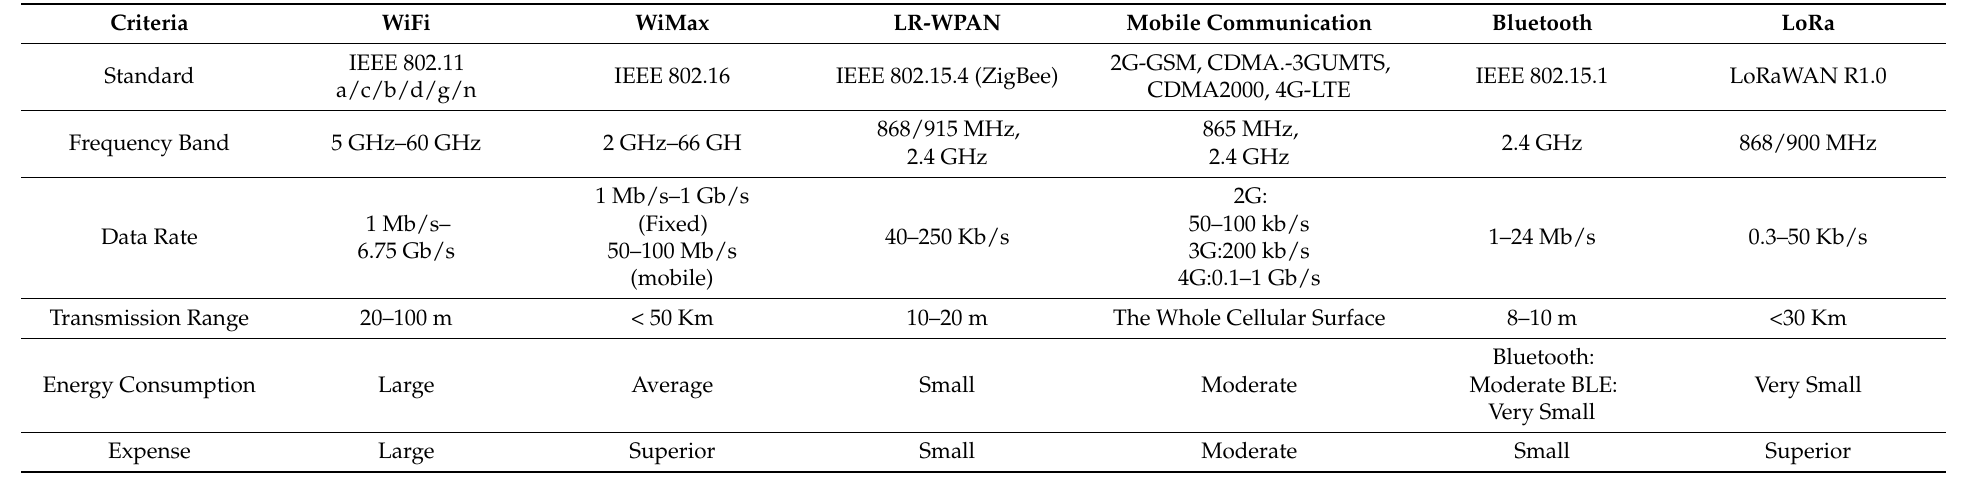
Table 5. A comparison of the emerging state of the art in networking technology.